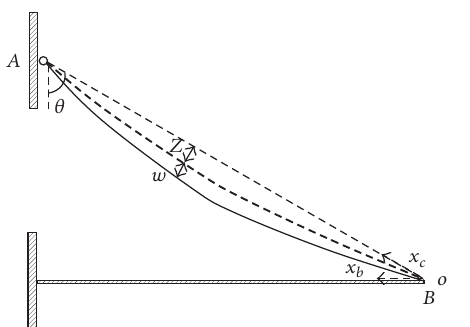
Figure 1: Parametric resonance refined model of cable-beam cou-